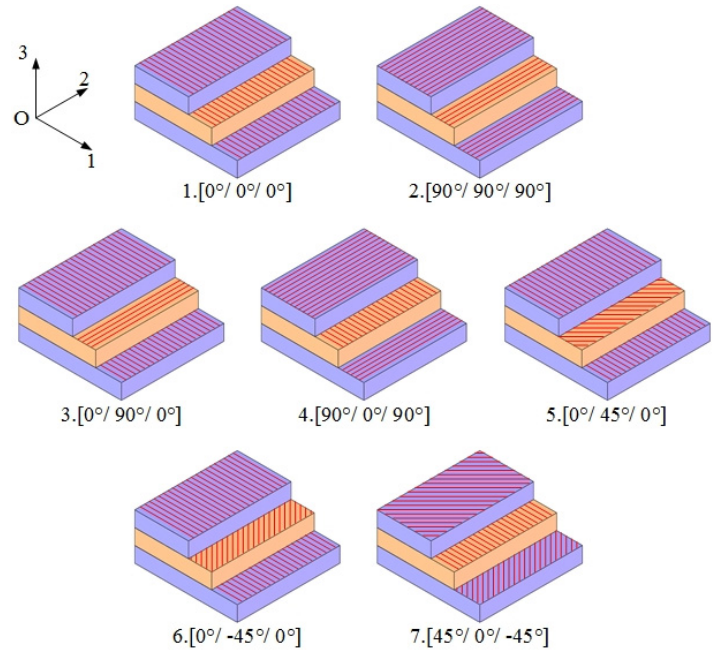
Figure 4. Layout scheme of each carbon fiber layer. Table 3. NNF simulation results of a multi-layered Miura tube.